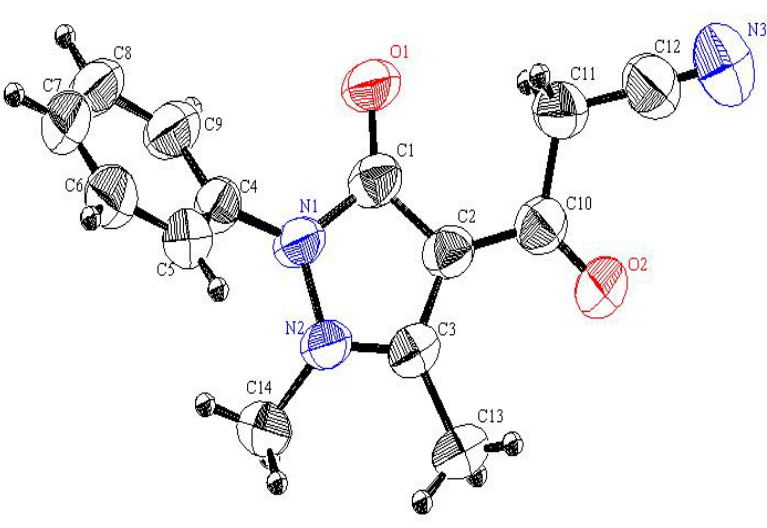
Figure 1. An ORTEP plot of the X-ray crystal structure of 3a